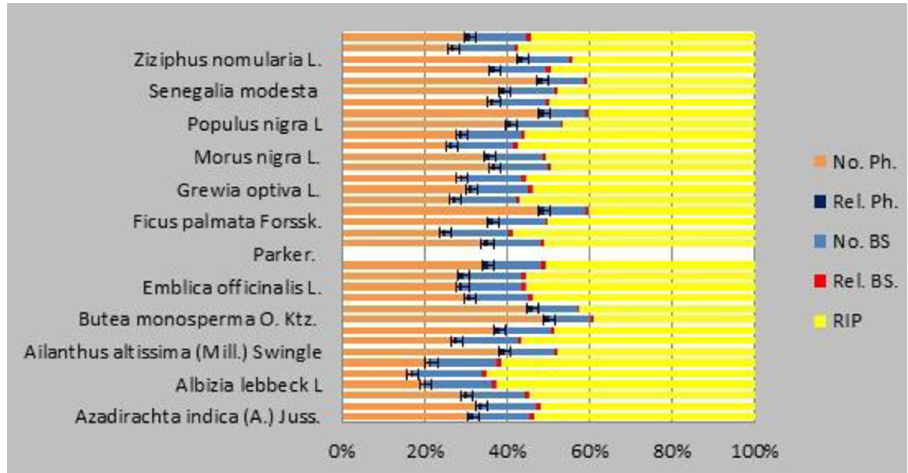
Fig 5. Relative importance of tree plants of Shiwalik Mountain Range of District Bhimber AJK, Pakistan.